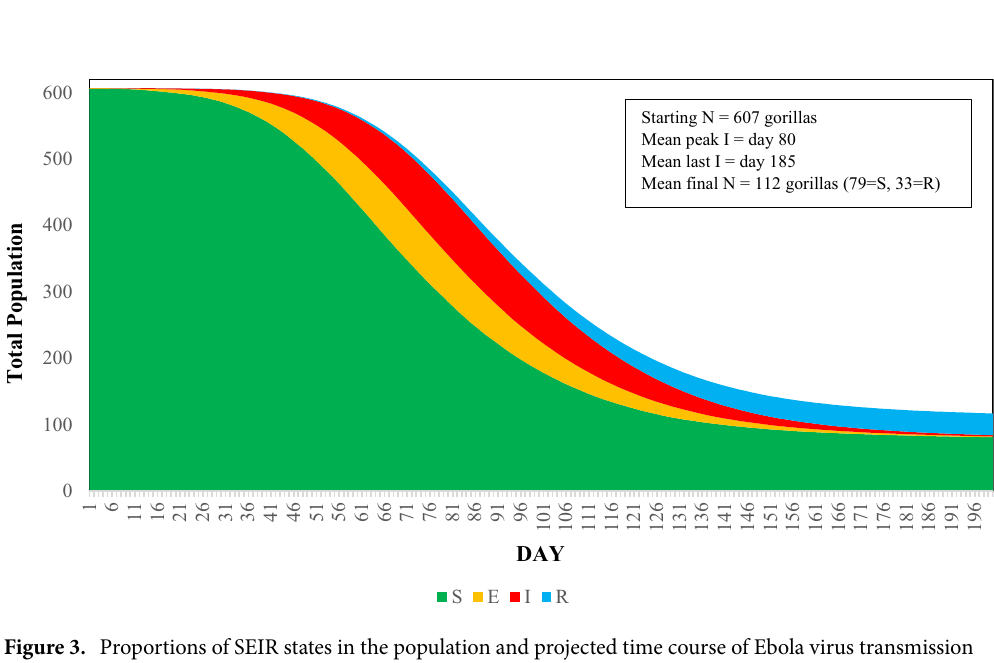
Figure 3. Proportions of SEIR states in the population and projected time course of Ebola virus transmission after entering the mountain gorilla population through one infected individual in the DRC-1 group at Day 0. S—Susceptible, never infected; E—Exposed and infected; I—Infectious; R—Recovered. Results averaged across 500